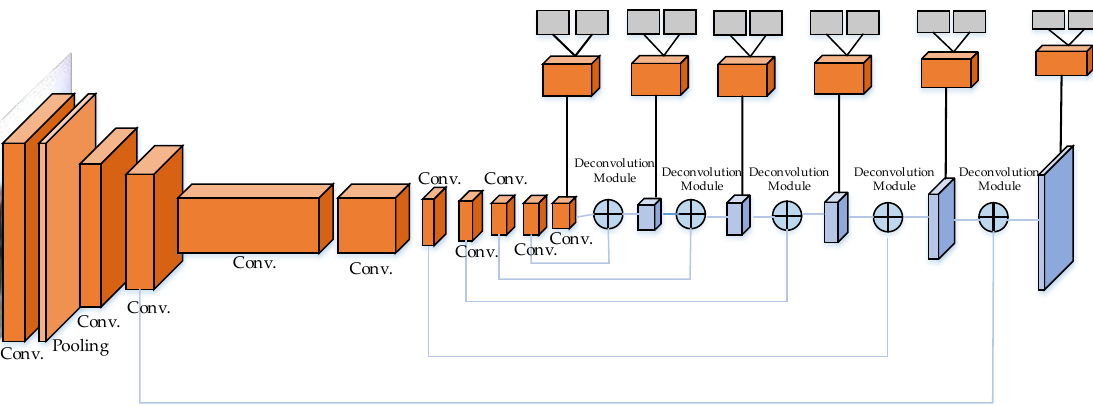
Figure 8. The structure of DSSD. The orange boxes are convolutional layers, the light-orange boxes are pooling layers, the lilac boxes are de-convolutional layers, the lilac gates represent the concatenation of the convolution and the deconvolution. There are 10 convolutional layers, 1 pooling layer and 5 de-convolutional layers in the main pipeline. The planes reflect the size of the feature maps, the thickness reflects the dimension of the feature map. The six branches on the top right of the figure represent the prediction module, i.e., classification and object localization module.